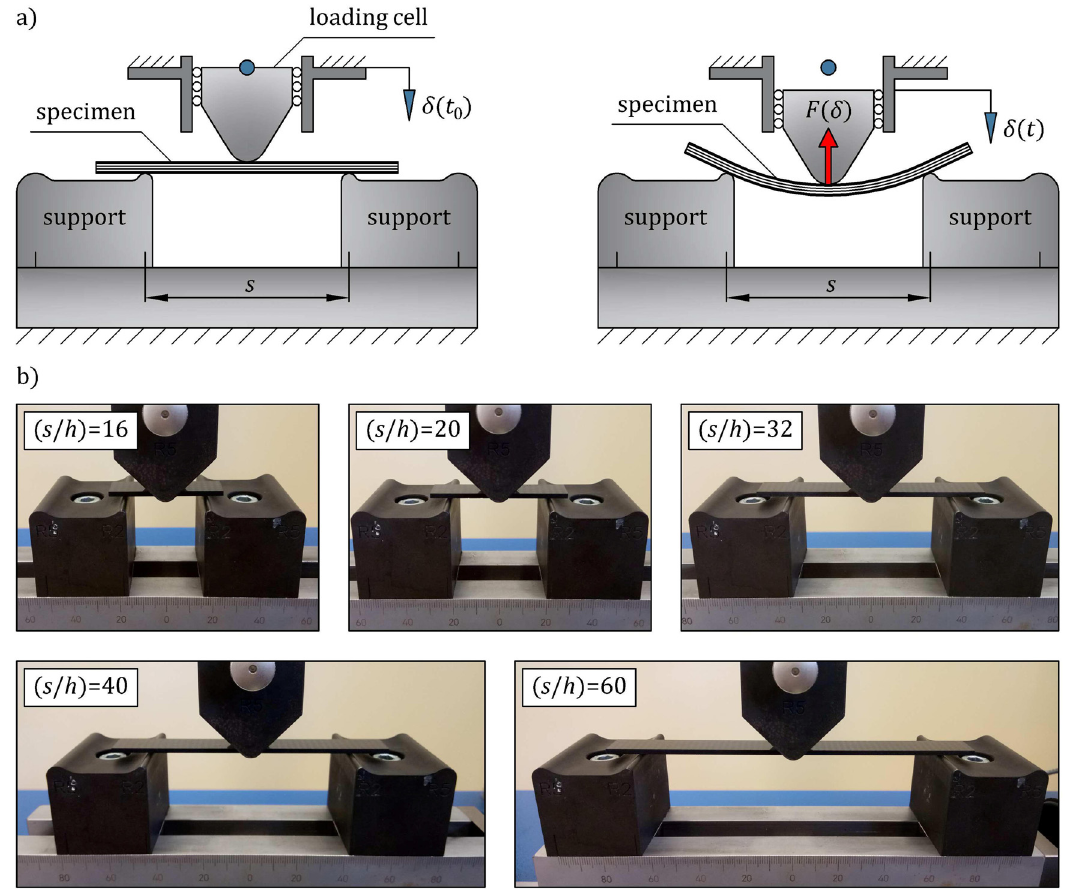
Figure 5: ( a ) Schematic diagram of fl exural testing setup and ( b ) photographs of the specimens tested at di ff erent ( s / h )